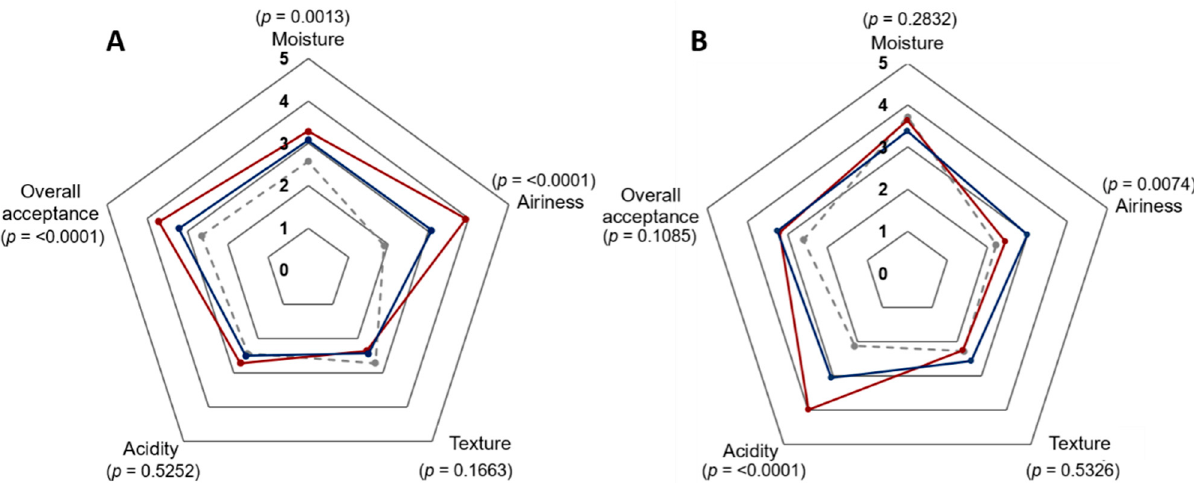
Figure 4. Consumer acceptability of β -glucan enriched wheat and rye breads. ( A ) Wheat bread with L. brevis TMW 1.2112 (red), P. claussenii TMW 2.340 (blue) compared to the control (dashed line, grey). ( B ) Rye bread with L. brevis TMW 1.2112, P. claussenii TMW 2.340 compared to the control. Data are presented in a 5-point hedonic scale. Sensory attributes with p ≤ 0.01 indicate a significant difference among the samples.